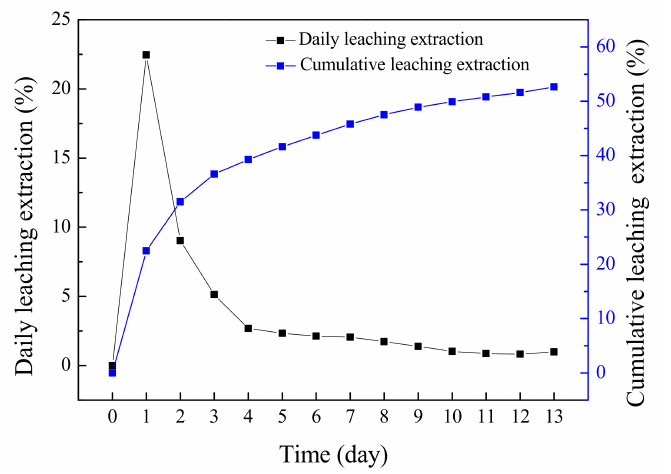
Figure 11. Gold leaching efficiency from ores by column leaching for 13 d. Cyanidation: pH 11, 200 ppm CN − , 8.2 mg/L DO.